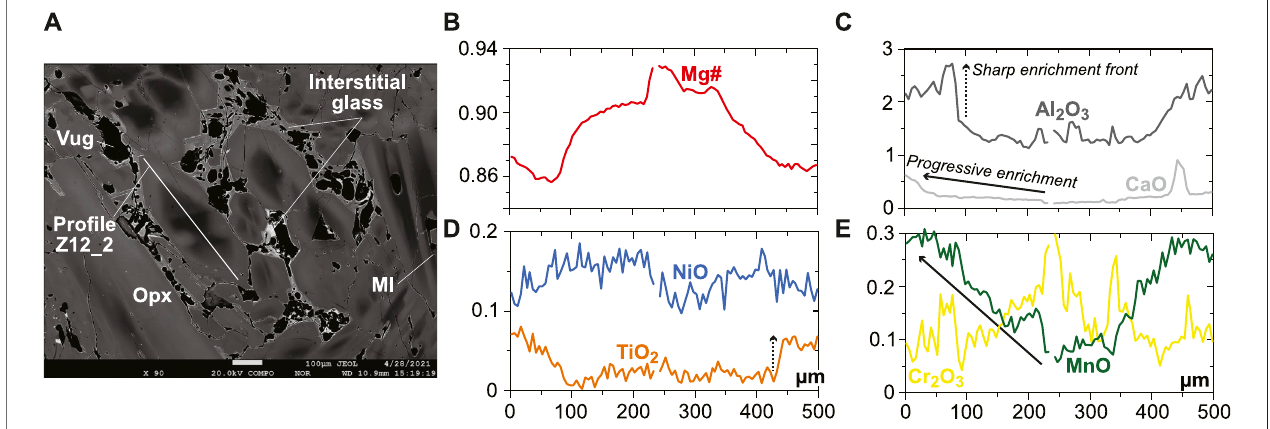
FIGURE 3 | Rim-to-rim pro fi le in a opx grain from the new Kamchatka vein in this study (in wt% for oxides). (A) BSE image (EPMA) showing the texture and zoning patternofalargeopxgrainlocatedintheglassycentralpartofthevein. (B – E) Rim-to-rimvariationsin (B) Mg#, (C) Al 2 O 3 ,andCaOcontents, (D) TiO 2 andNiOcontents, and Cr 2 O 3 and MnO contents for the pro fi le in (A) . Note the skeletal-hopper texture outlined by the high-Mg# core of the opx grain and the sharp vs. progressive increases for elements of different degrees of incompatibility.